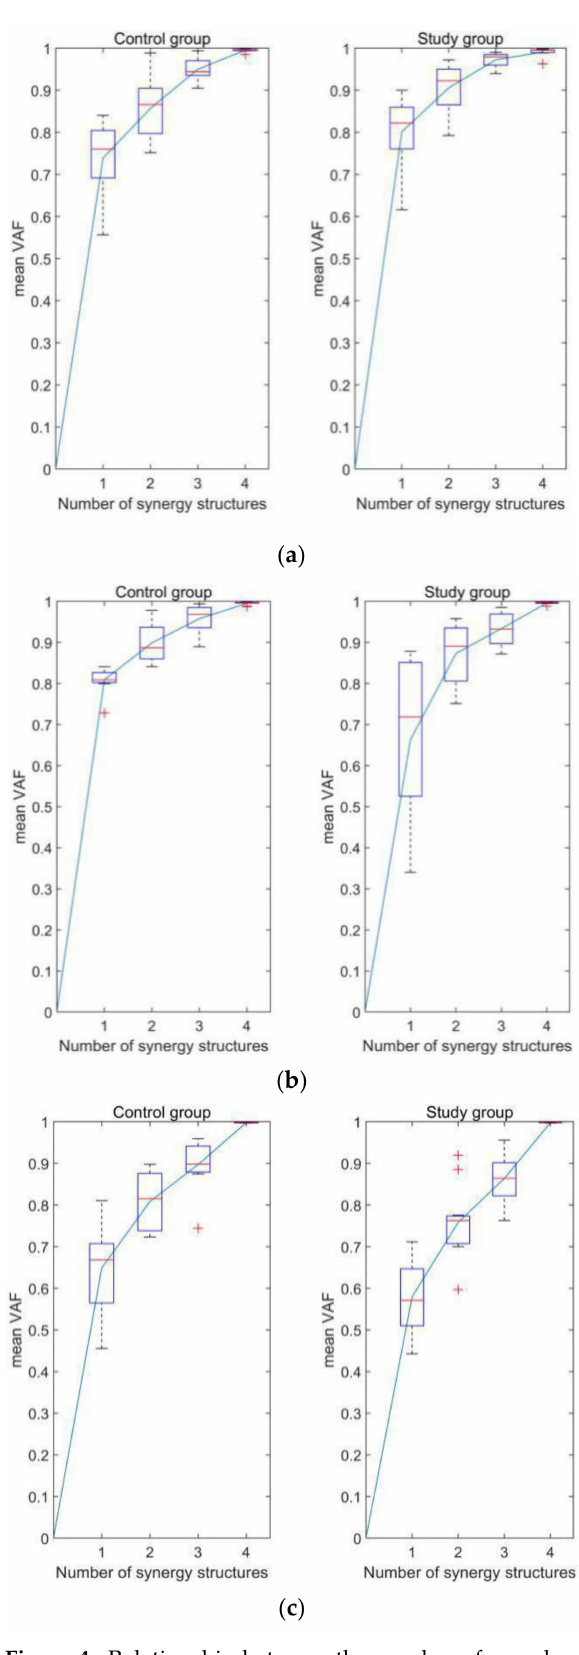
Figure 4. Relationship between the number of muscle synergy structures and the mean VAF in different groups when performing different lower limb motions. ( a ) STD, ( b ) ST, and ( c ) Gait. The ‘+’ in the figure represents the